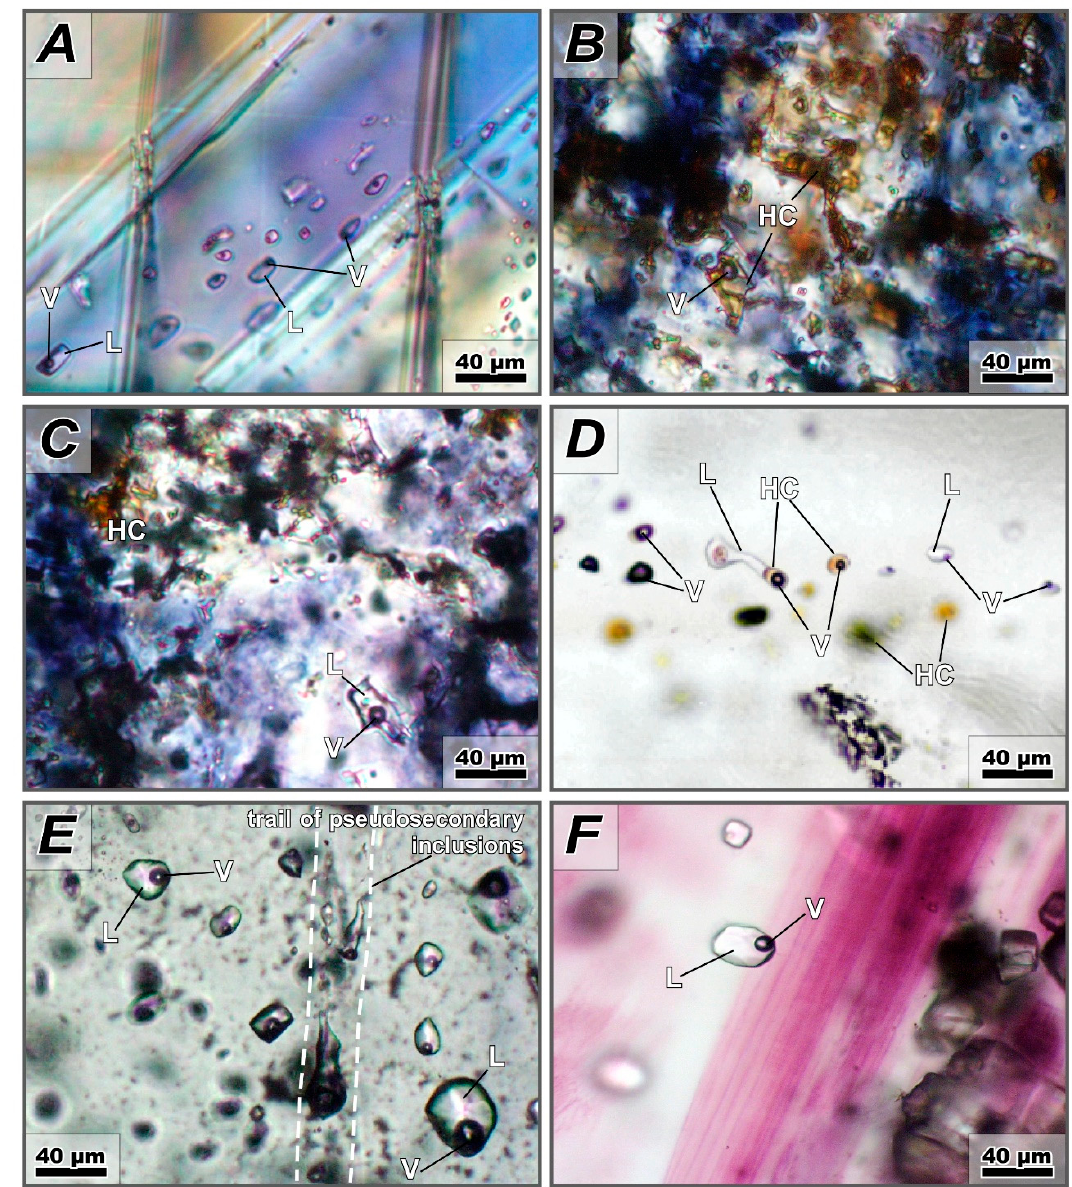
Figure 8. Photomicrographs of the analysed fluid inclusions for MVT-like ( A to C ) and late hydrothermal fluorite deposits ( D to F ) in the Aguachile area, Coahuila. ( A ) Pseudosecondary two-phase liquid-rich aqueous inclusions in purplish fluorite. ( B to D ) Primary inclusions in fluid inclusion assemblages that attest to heterogeneous trapping of hydrocarbon (yellowish to brown) and aqueous liquids, in purple (MVT-like) to colourless (late hydrothermal) fluorite. ( E , F ) Primary fluid inclusions in late hydrothermal fluorite, as isolated groups crossed by pseudosecondary inclusions ( E ) or following crystal zoning marked by changes in colour ( F ). Notice the variability in the relative volume that hydrocarbons and aqueous fluids occupy in individual inclusions. Key: HC = liquid hydrocarbon, L = aqueous liquid, V = vapour.